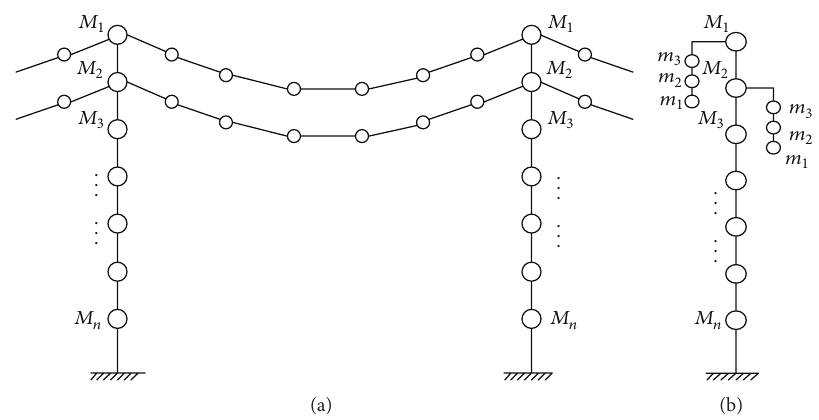
Figure 3: Analytical model of a transmission tower-line system. (a) In-plane vibration. (b) Out-of-plane vibration.